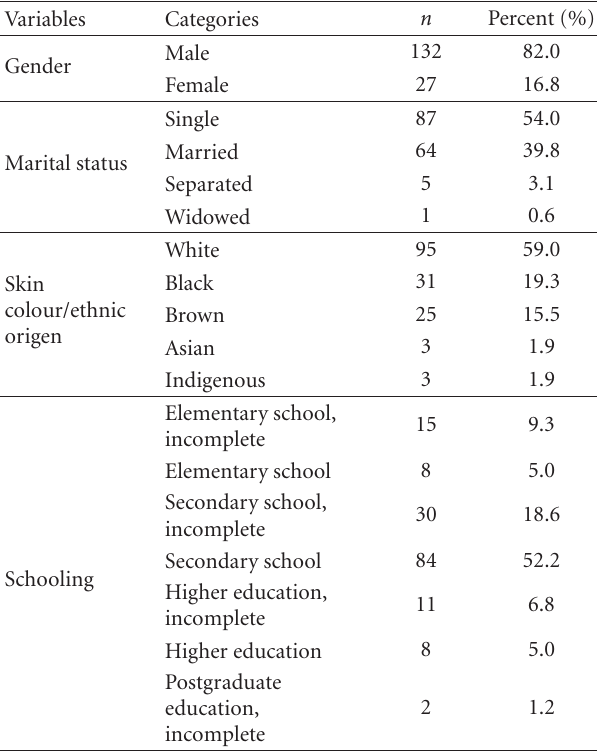
Table 1: Demographic characteristics of the study subjects ( n = 161) ∗